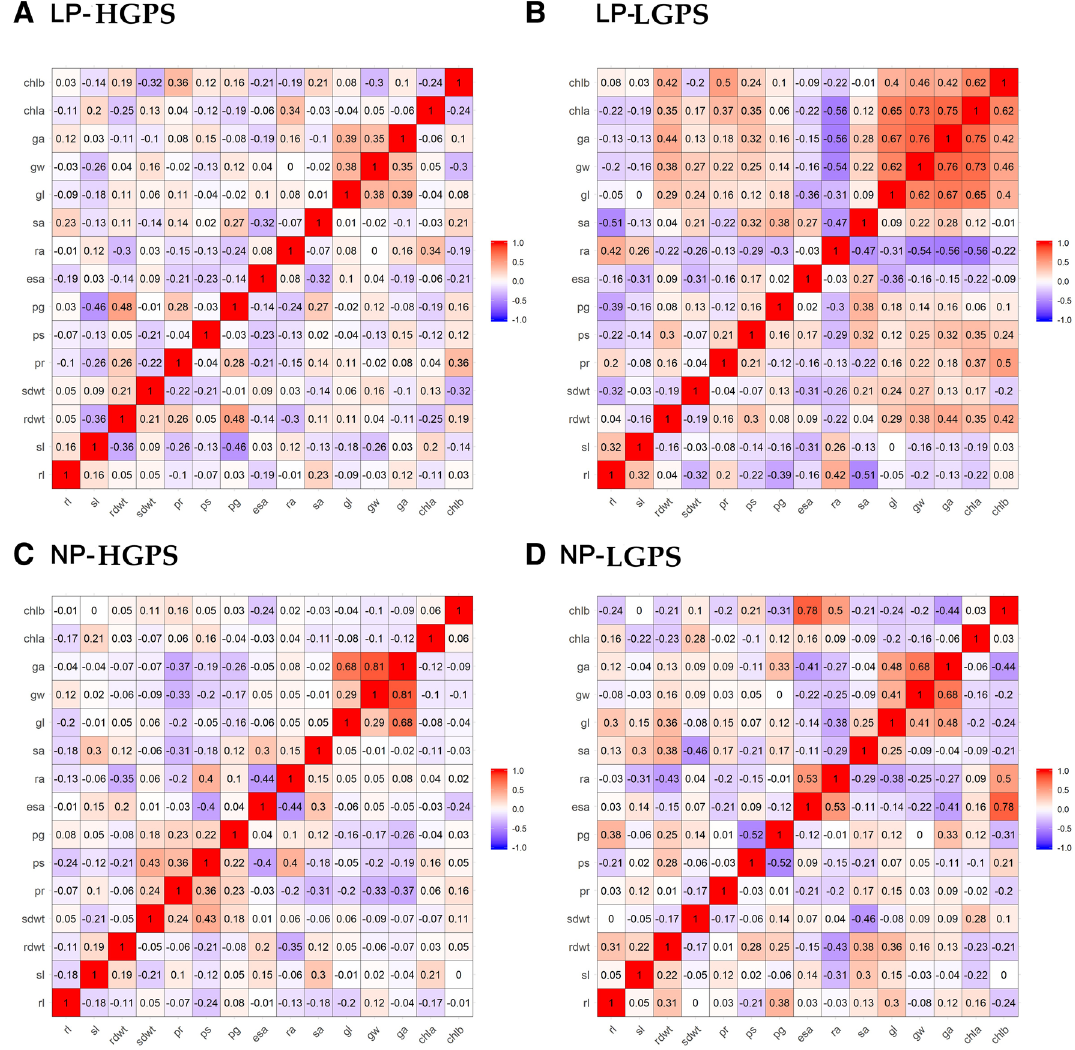
Figure 16. Correlogram of traits under LP and NP conditions in HGPS and LGPS at 12 days. The scale represents Pearson correlation values. Blue and red colours represent negative and positive correlation, respectively. root length (rl), shoot length (sl), root dry weight (rdwt), shoot dry weight (sdwt), P content in root (pr), P content in shoot (ps), P content in grain (pg), externally secreted acid phosphatase (esa), root acid phosphatase (ra), shoot acid phosphatase (sa), grain length (gl), grain width (gw), grain area (ga), chlorophyll A content (chla), chlorophyll B content